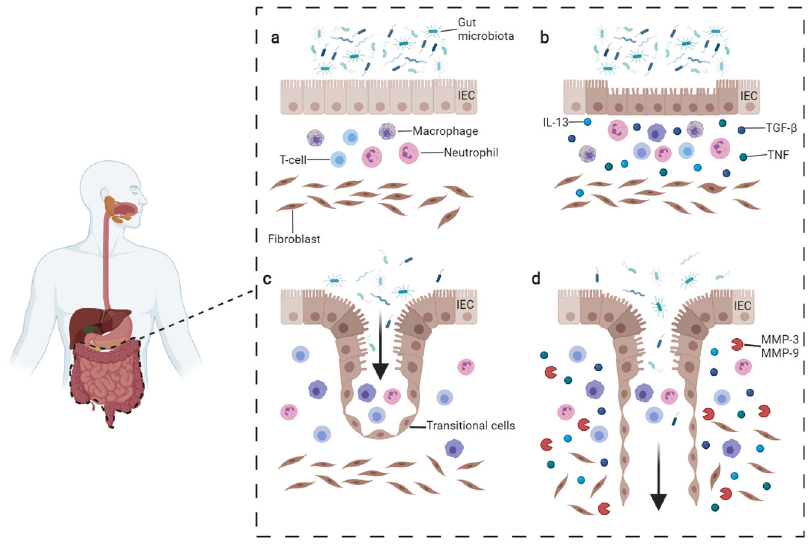
Figure 1. Pathogenesis of CD fistula. ( a ) Normal condition persisting in the gut. ( b ) In CD, the intestinal lesions can be triggered by multiple factors such as inflammatory cells reacting to